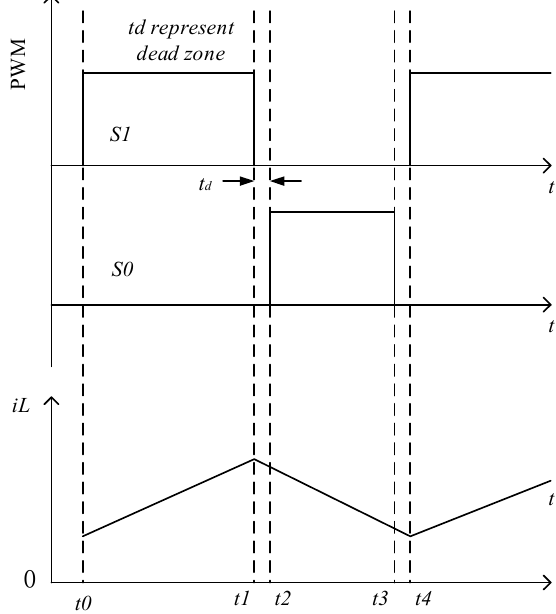
Figure 3. Theoretical waveform of inductor current in buck mode.